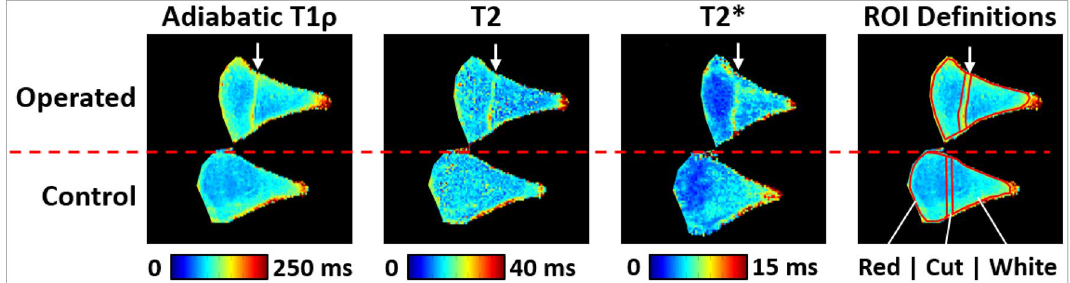
Figure 2. Quantitative relaxation time maps and region of interest (ROI) definitions for a representative pair of operated and control menisci at the cranial aspect of the menisci and root end of the tear site. The location of the tear is indicated by the arrow. In this example, relaxation times are increased in the vicinity of the tear site, while relaxation times in the white and red zones are similar between the operated and control